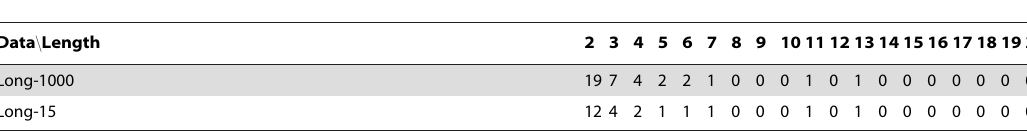
Table 3. Comparison of GMM long proximal models with different filters.